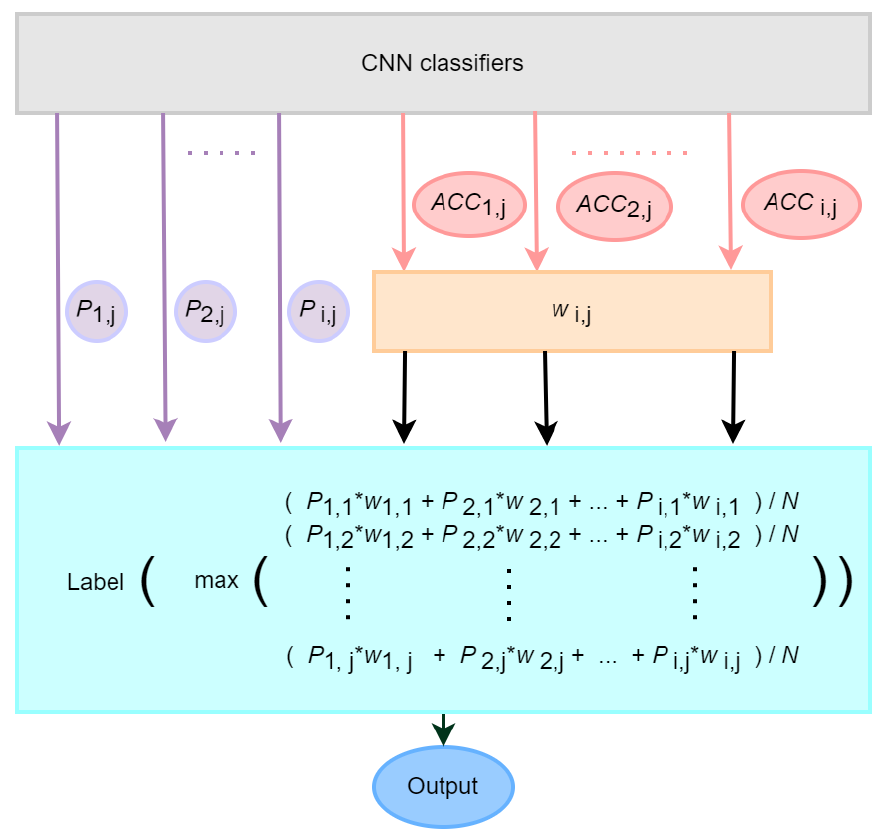
Figure 3. The process of the proposed accuracy-based weighted voting (AWV) algorithm.